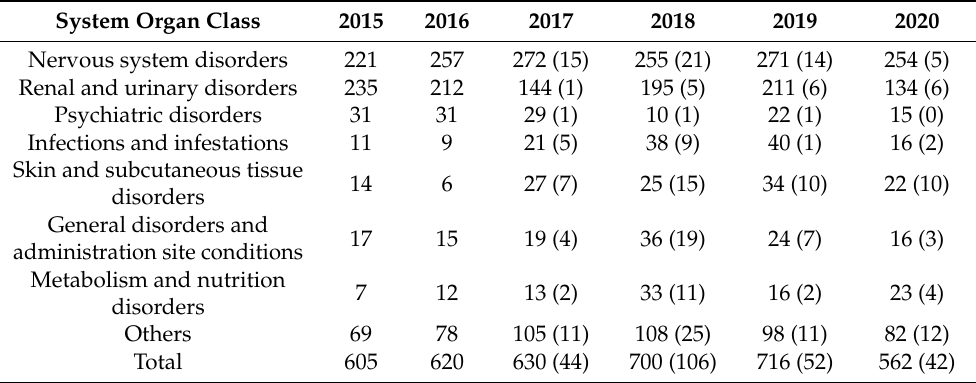
Table 3. Cumulative number of adverse drug reactions related to oral anti-herpetic drugs (as of 16 May